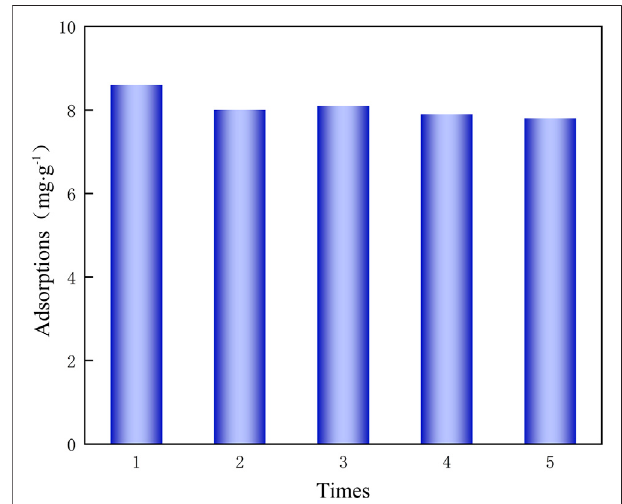
FIGURE7| AdsorptioneffectsofPAN-CE@SiO 2 /zeoliteondifferentions at pH values of 4, 6, and 8.